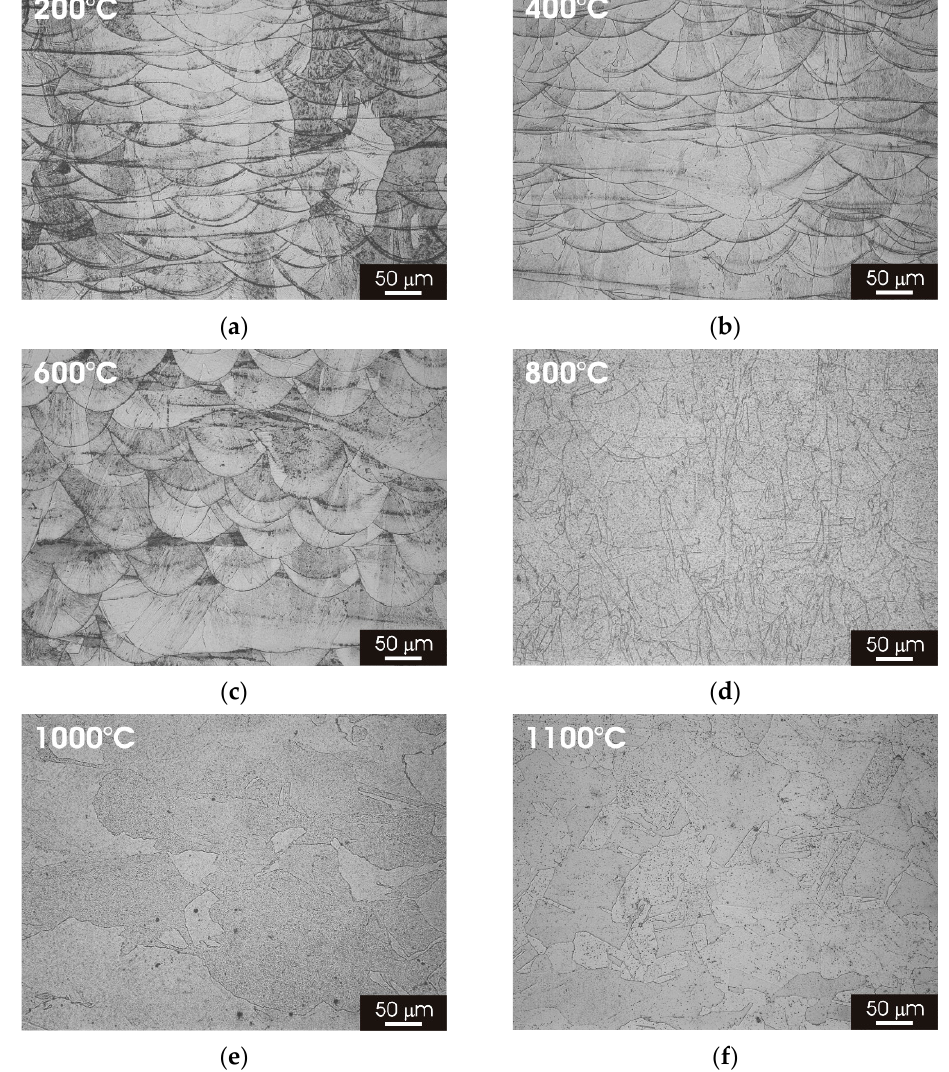
Figure 5. Optical micrographs of L-PBF-XZ 316L stainless steel after 2 h thermal treatment. ( a ) 200 ◦ C;